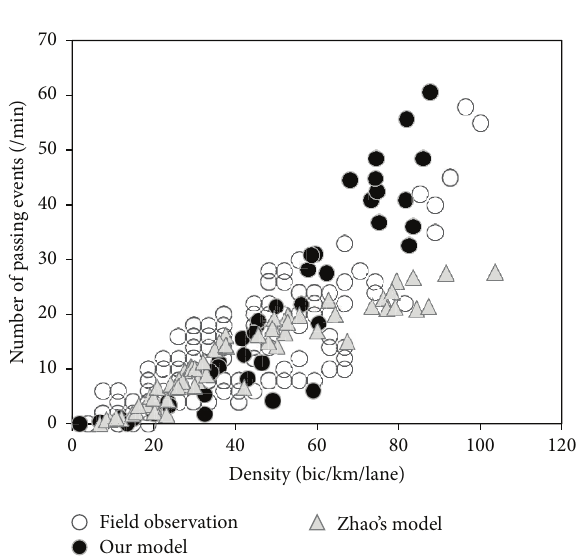
Figure 4: Comparison of number of passing